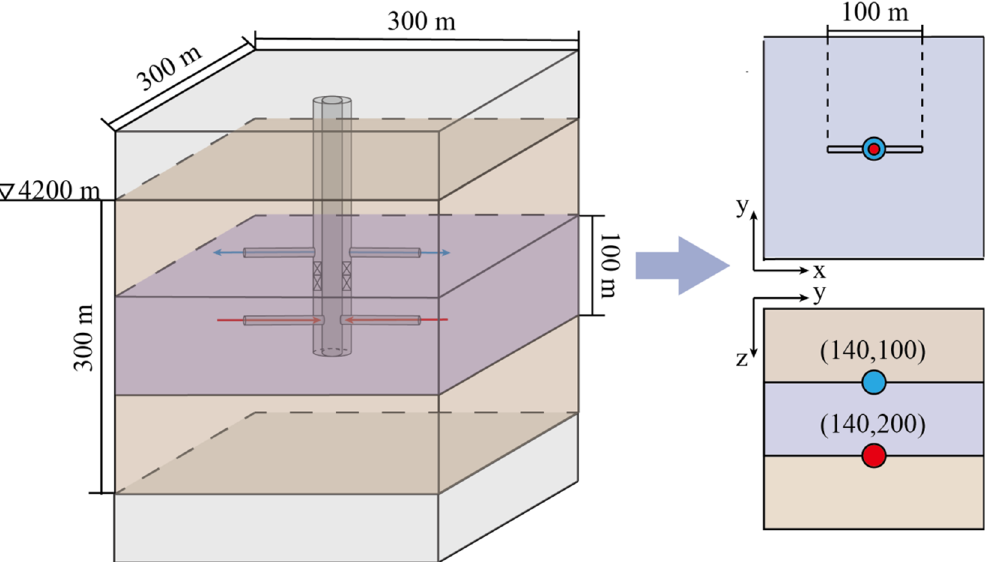
Figure 11. Physical models of the conventional double vertical wells model, horizontal wells, and double ‐ pipe heat exchange system.